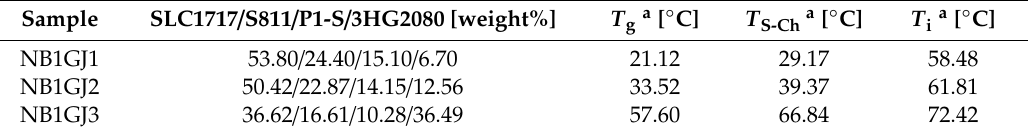
Scheme 1. The chemical structures of the materials used in this work. Table 1. The compositions and phase transitions of all the samples. Table 1. The compositions and phase transitions of all the